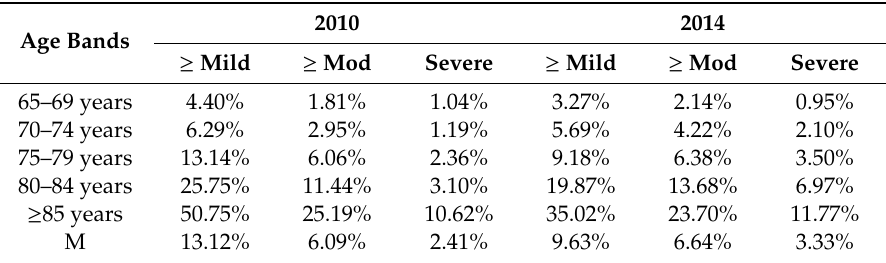
Table 2. Disability prevalence in 2010 and 2014 by age.